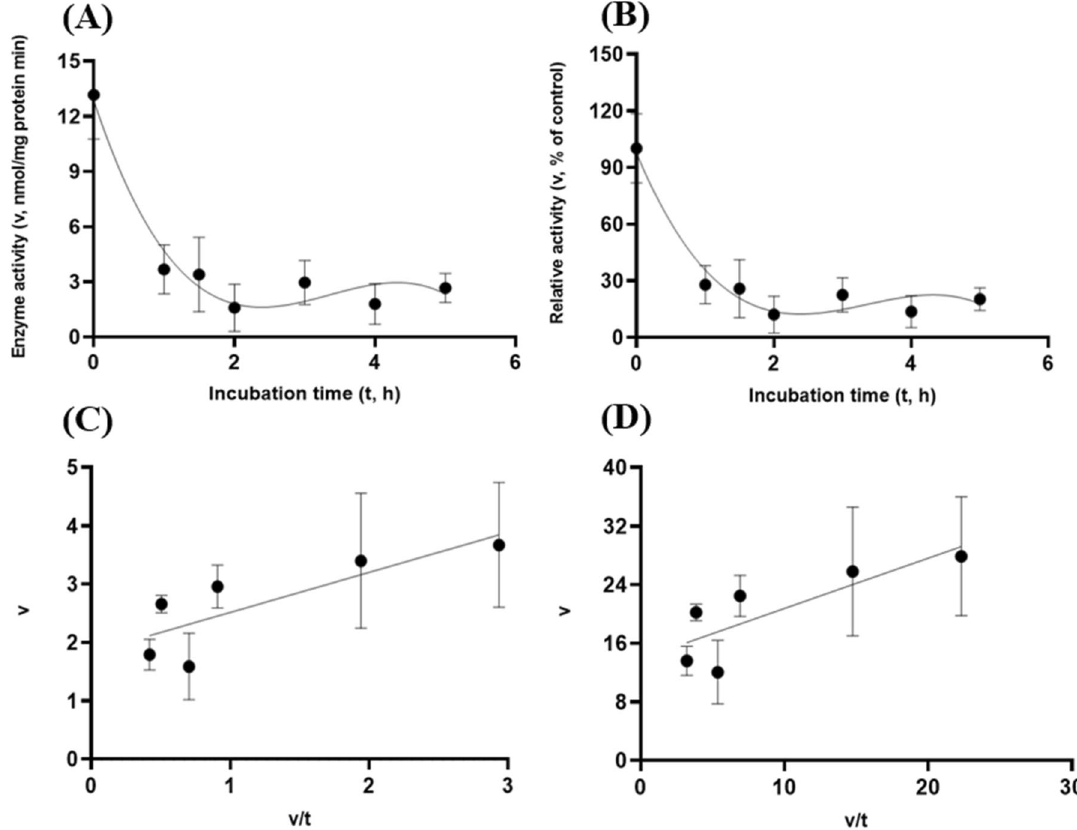
Figure 12. Experiment-3 of the intestinal pancreatic trypsin (78 U/mL) effects (with describing model parameter estimates ± SE ) on GH5-tCel5A1 activity over a 5-h period after the intestinal pancreatic trypsin buffer being mixed with the GH5-tCel5A1enzyme preparation for incubation at the resulting mixture pH = 6.0–7.0 and trypsin (78 U/mL) prior to further incubation for measuring cellulase activity with the carboxymethyl cellulose (CMC) substrate buffer in presence of dithiothreitol (DTT) (5 mM) and N 2 gas purging for 15 min at 37 °C. (A) Plot of the inhibition kinetic relationship between the GH5- tCel5A1 activity (v, mean ± SE, n = 12at each time point, nmol/mg protein•min) and incubation time (t, h) under the trypsin (78 U/mL) condition established according to the cubic response model as: Y = 16.140 ( ± 2.166 ) − 13.659 ( ± 3.342 ) x + 4.087 ( ± 1.451 ) x 2 − 0.378 ( ± 0.176 ) x 3 , P < 0.0001 for the intercept; P = 0.0001 for the linear parameter; P = 0.006 for the quadratic parameter estimate; and P = 0.035 for the cubic parameter, R 2 = 0.326 , n = 84; and alternatively, according to the linear regression model as: y = 7.930 ( ± 1.251 ) − 1.459 ( ± 0.405 ) x , P < 0.0001 for the intercept; and P = 0.001 for the slope, r 2 = 0.142 , n = 84; (B) Plot of the inhibition kinetic relationship between the relative GH5-tCel5A1 activity (v, mean ± SE, n = 12at each time point, % of the control group measured at I c of 100.000 ± 18.294 at 0-min exposure to the trypsin-78-U/mL incubation) and incubation time (t, h) established according to the cubic response model: Y = 122.6 ( ± 16.458 ) − 103.8 ( ± 25.393 ) x + 31.050 ( ± 11.026 ) x 2 − 2.875 ( ± 1.338 ) x 3 , P < 0.0001 for the intercept ; P = 0.0001 for the linear parameter estimate ; P = 0.006 for the quadratic parameter estimate; and P = 0.035 for the cubic parameter estimate, R 2 = 0.326 , n = 84; and alternatively, according to the linear regression model established as: y = 60.251 ( ± 9.5 ) − 11.091 ( ± 3.077 ) x , P < 0.0001 for the intercept; and P = 0.001 for the slope; r 2 = 0.142 , n = 84; (C ) the Eadie-Hofstee linear plot between the GH5- tCel5A1 enzyme activity (v, mean ± SE, n = 12at each data point, nmol/mg protein•min) and the v/t ratio established as: y = 0.681 ( ± 0.251 ) + 1.639 ( ± 0.090 ) x , P = 0.008 for the intercept; and P < 0.0001 for the slope, r 2 = 0.829 , n = 72; and (D ) the Eadie-Hofstee linear plot between the relative GH5-tCel5A1 enzyme activity (v, mean ± SE, n = 12at each data point, % of the control group measured at I c of 100.000 ± 18.294) at 0-min exposure to the trypsin-78-U/mL incubation) incubation] and the v/t ratio established as y = 5.173 ( ± 1.904 ) + 1.639 ( ± 0.090 ) x , P = 0.008 for the intercept; and P < 0.0001 for the slope; r 2 = 0.829 , n =